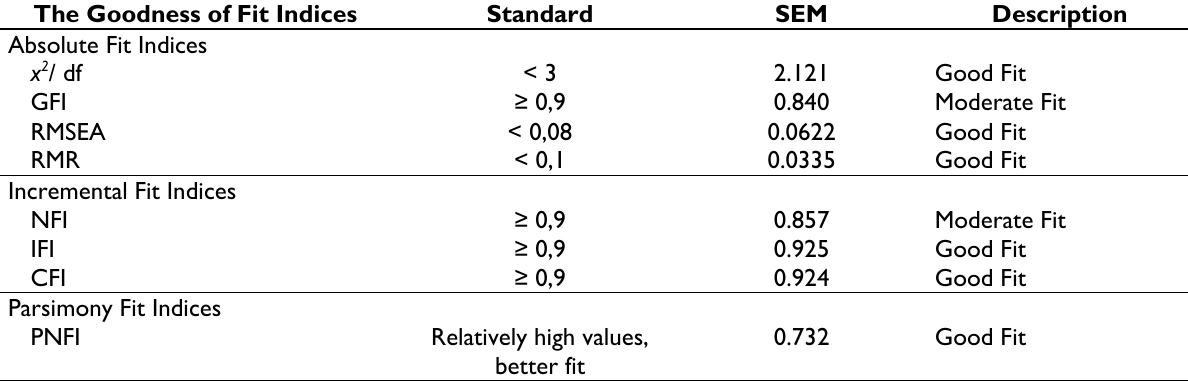
Table 5. The goodness of fit